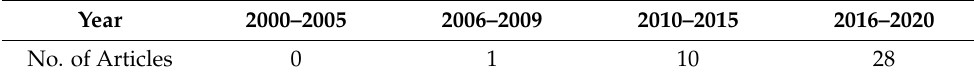
Table 10. Distribution of MCDA mixed-method techniques from 2000 to